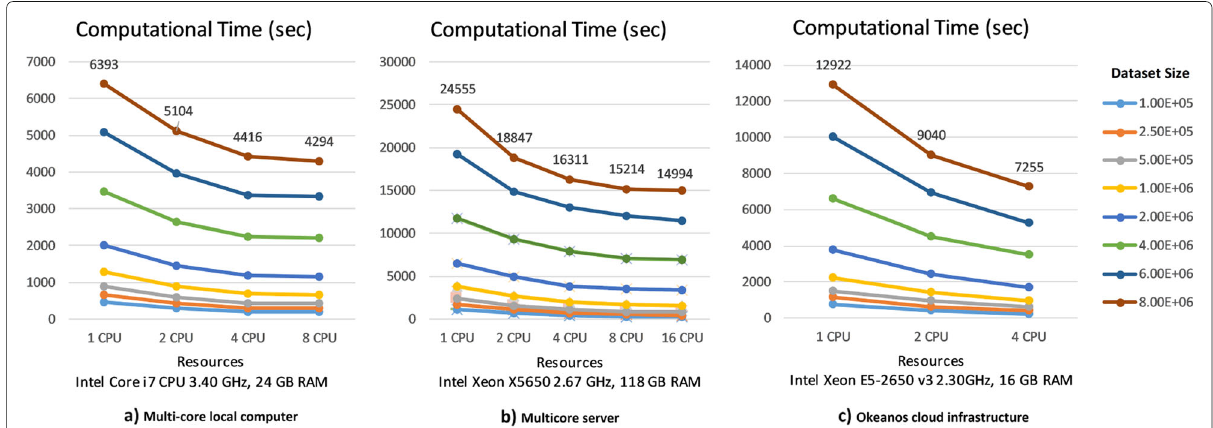
Fig. 3 Computational time of the FBHC algorithm using subsets of the PubMed dataset running as a docker image on a local server and in a cloud infrastructure